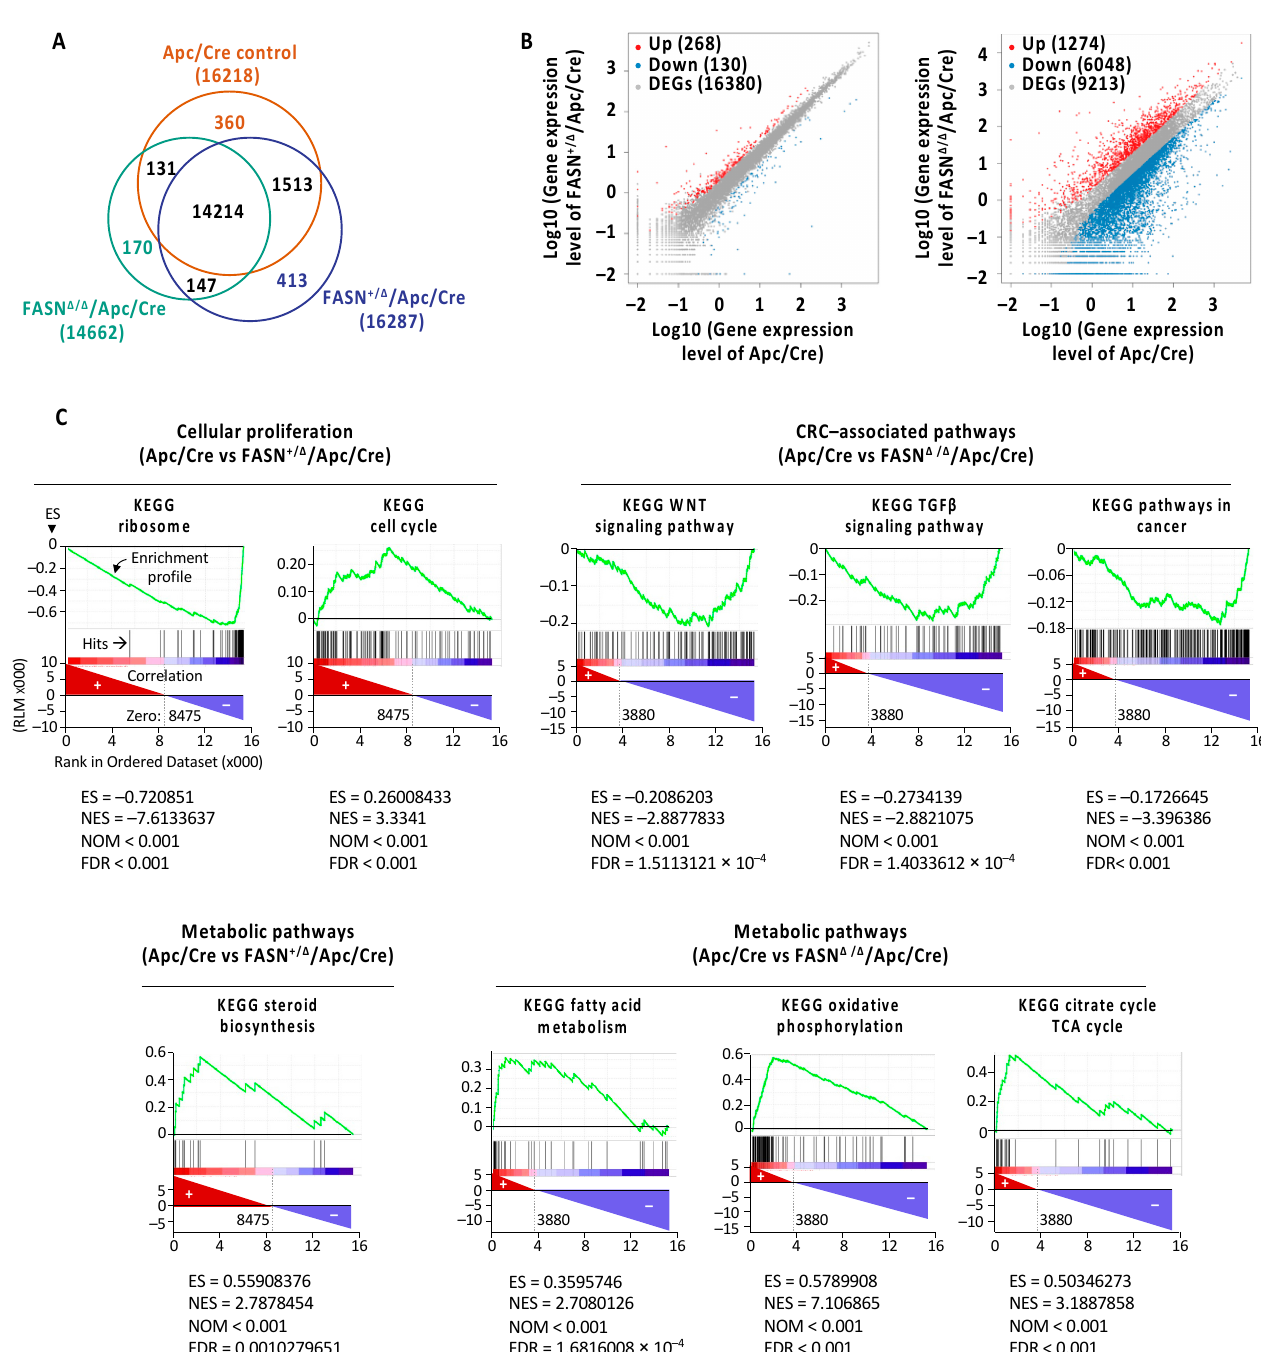
Figure 2. FASN promotes adenoma formation via upregulation of pathways involved in cell growth and energy metabolism. ( A ) Venn diagram displaying the overlapping genes identified in tumors from Apc/Cre mice and Apc/Cre mice with heterozygous and homozygous expression of FASN. ( B ) Scatter plots showing the numbers of differentially expressed genes in Apc/Cre mice and Apc/Cre mice with heterozygous and homozygous expression of FASN. Significantly changed DEGs are indicated in colors. Red and blue dots are up- and downregulated genes, respectively. The detailed lists of differentially expressed genes are provided in Table S2A. ( C ) Representative gene set enrichment analysis plots generated from RNA-Seq expression data of Apc/Cre and FASN knockout mice. The bar codes indicate the location of the members of the gene set in the ranked list of all genes. ES, enrichment score; NES, normalized enrichment score; NOM, nominal p -value; FDR, false discovery rate adjusted p